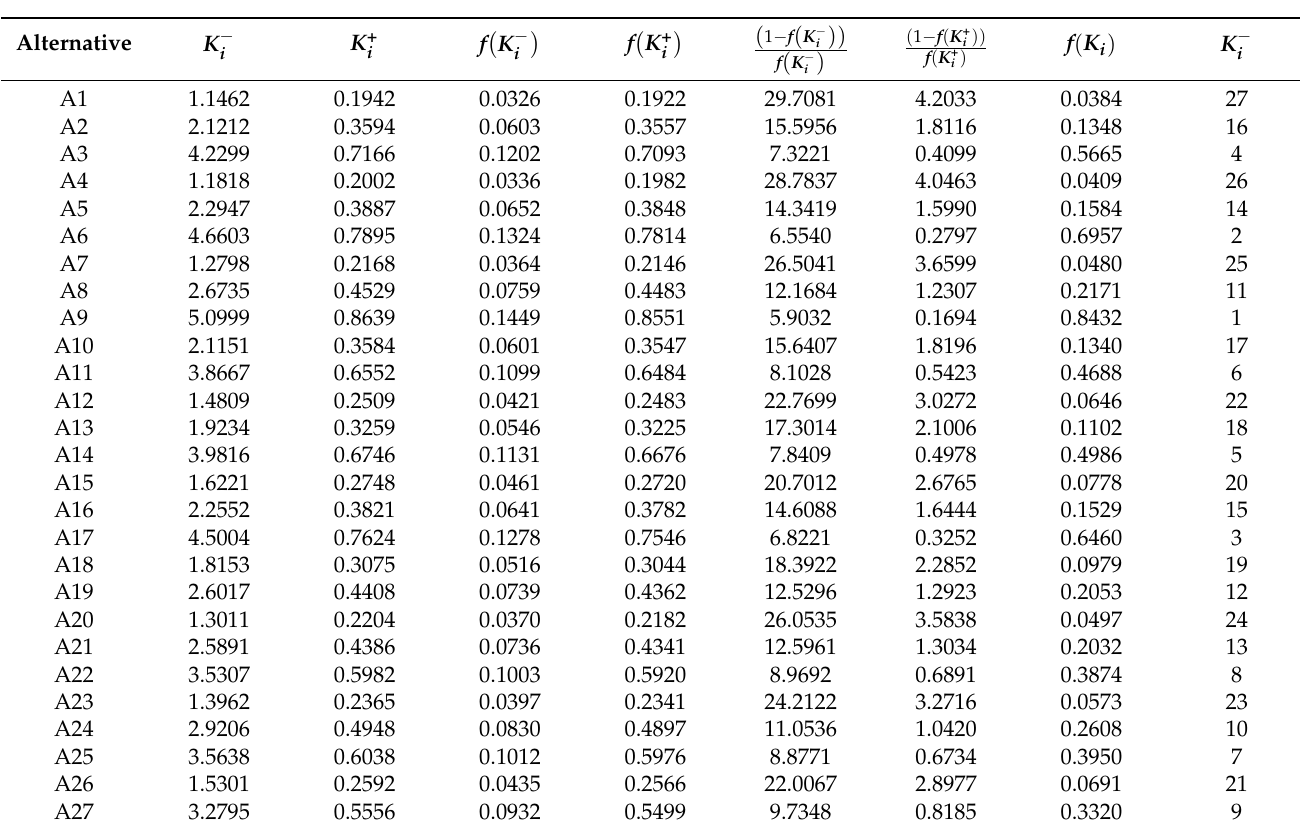
Table 10. Defuzzied utility degree, utility functions, and ranks of the alternatives (case study